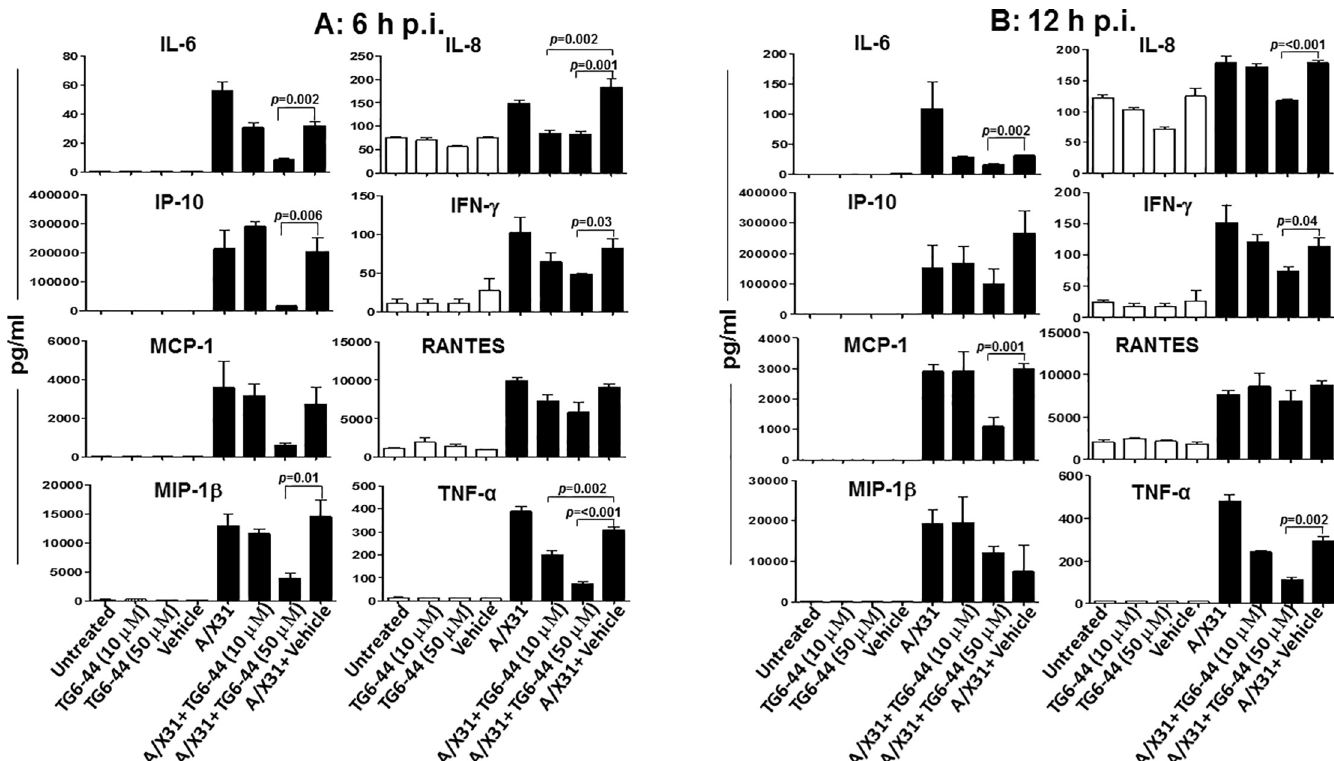
Fig 2. TG6-44 treatment leads to suppression of A/X31-induced inflammatory mediators in THP-1 cells. Cell culture supernatants from A/X31-infected THP-1 cells treated with either vehicle and/or TG6-44 were harvested at 6 h (A) and 12 h (B) p.i. and assayed for inflammatory mediators by Bio-Plex assay, as described in Materials and Methods. Data represent results from four independent experiments. Values represent mean ±